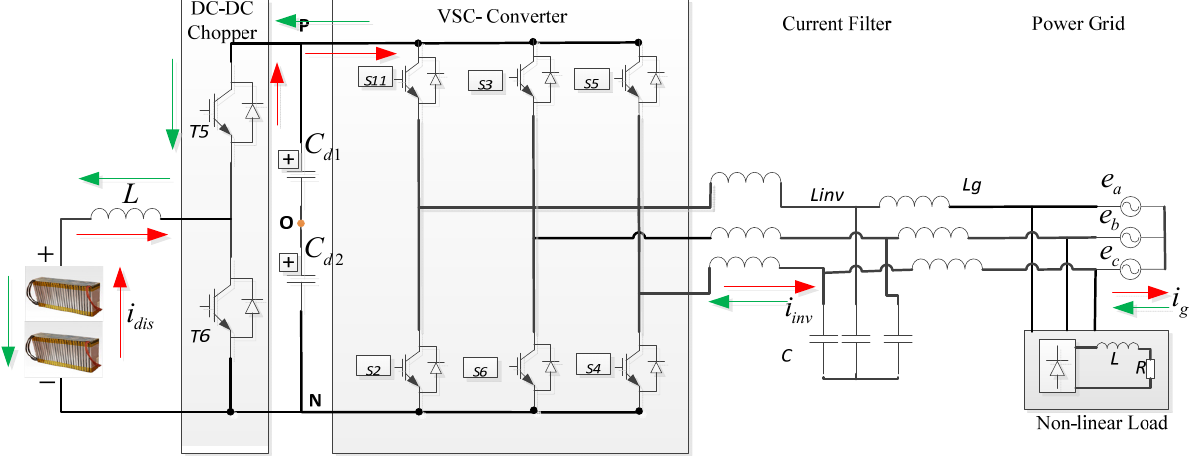
Figure 1. Power circuit configuration for energy recovery power accumulator battery pack testing system (ERPAPBTS) considering a non-linear load. DC: direct current; and VSC: voltage source